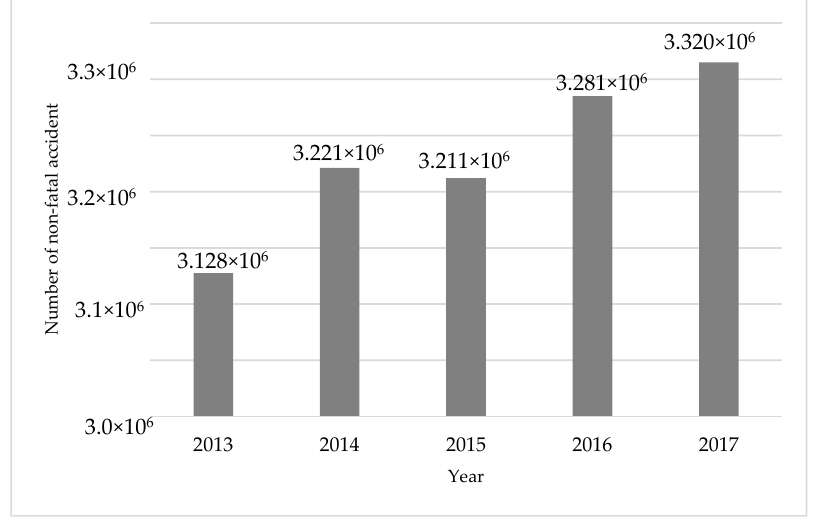
Figure 1. The non-fatal accident situation in the European Union during 2013–2017 [1].